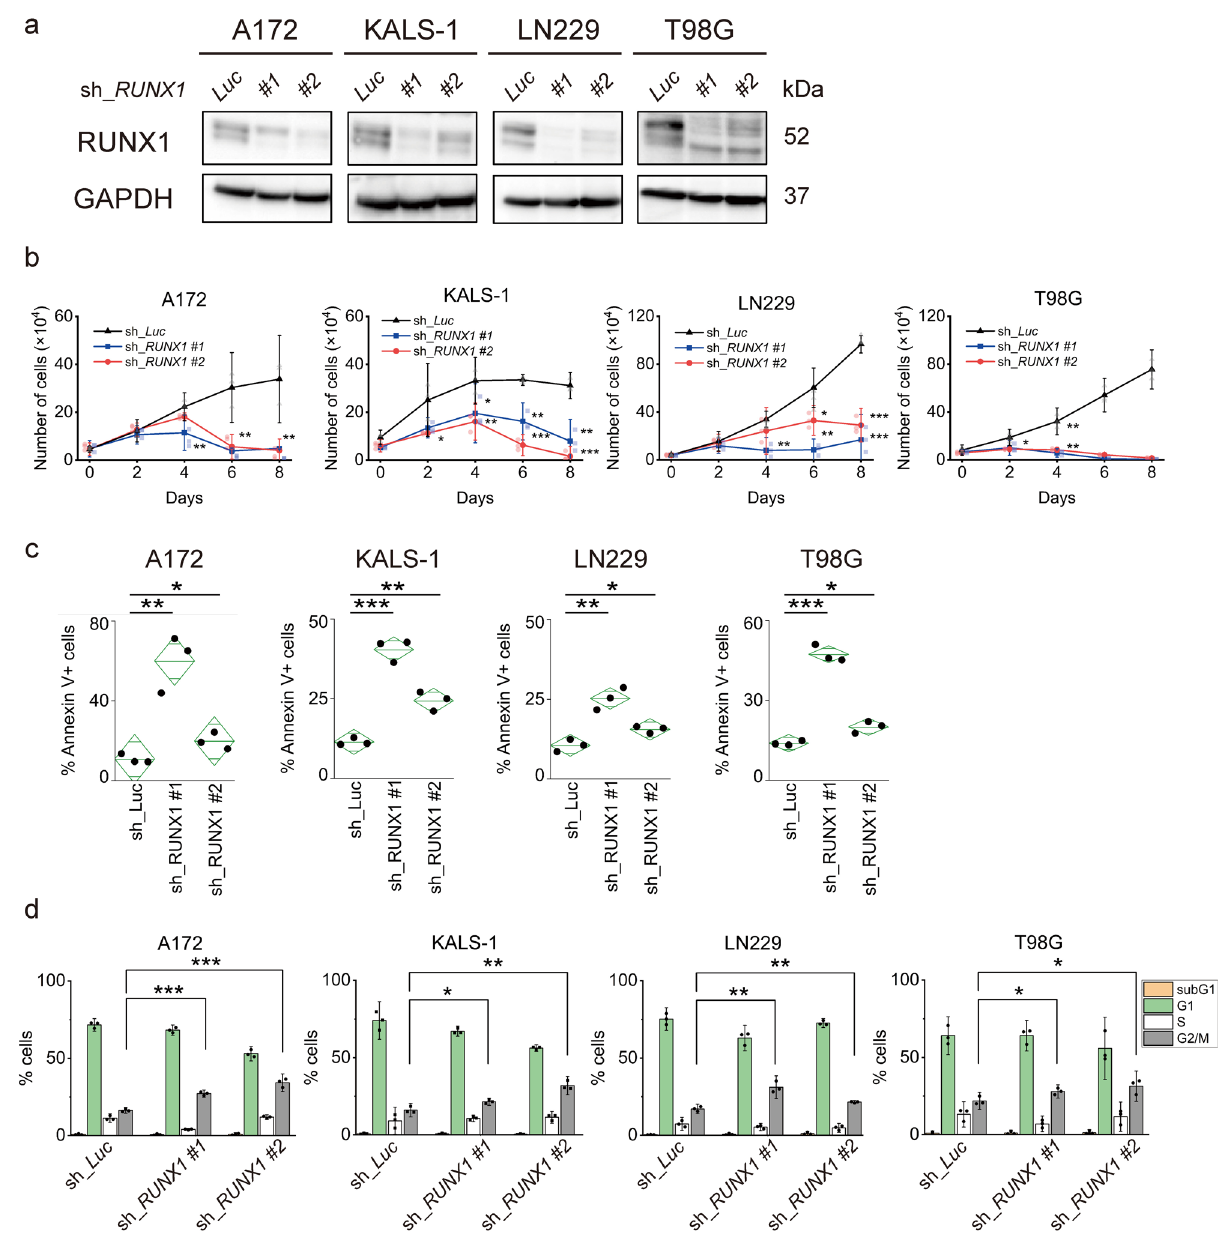
Fig. 2 Suppression of RUNX1 induces apoptosis and cell cycle arrest in glioblastoma cells. a Immunoblotting of each GBM cell line transduced with control or RUNX1 shRNAs. Control (sh_Luc) and sh_RUNX1 cells were cultured in the presence of 5 μ M of doxycycline. b Growth curves of A172, KALS-1, LN229 and T98G cells transduced with control (sh_Luc) or with RUNX1 shRNAs (#1 and #2) in the presence of 5 μ M of doxycycline. n = 3. c RUNX1 depression-induced apoptosis. Nondepleted and RUNX1-depressed A172 and LN229 were treated in the presence of 5 μ M of doxycycline for 6 days, KALS- 1 and T98G were treated for 4 days. The line in the centre of the rhombus indicates the mean value, and the vertical width indicates the 95% CI. n = 3. d RUNX1 depression induced cell cycle arrest. G2/M DNA content of cells was increased. Nondepleted and RUNX1-depressed cells were treated in the presence of 5 μ M of doxycycline for 4 days. Cells were analysed by fl ow cytometry. n = 3. Data represent mean ± 95% CI. * p < 0.05, ** p < 0.01, *** p < 0.001, by two-tailed Student ’ s t